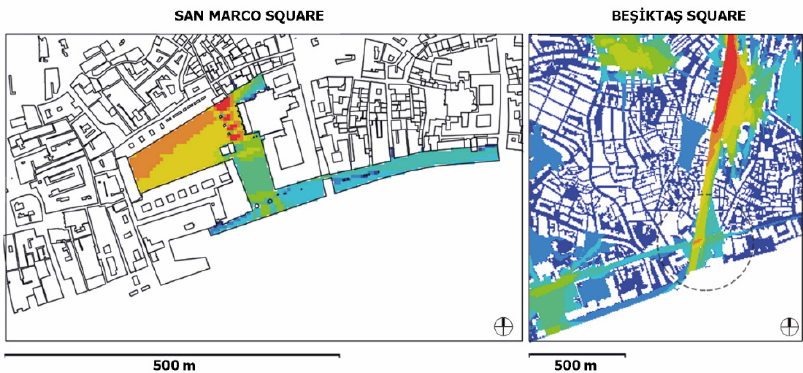
Figure 5. Visibility graph analysis (VGA) of